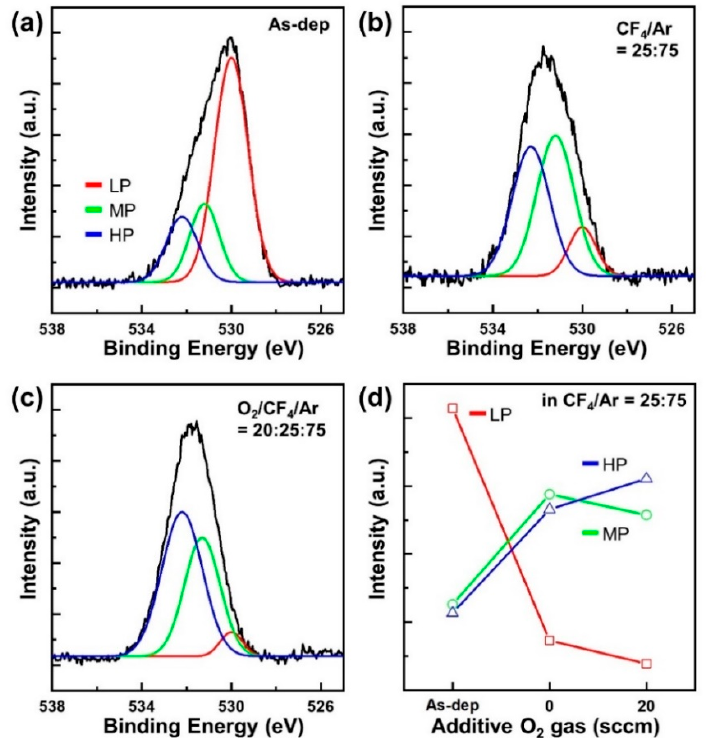
Figure 4. ( a ‒ c ) O 1s peaks of XPS narrow-scan spectra of the IGZO thin film and ( d ) intensity corresponding to low peak, middle peak and high peak as a function of additive O 2 flow rate with fixed CF 4 /Ar = 25:75 sccm. LP, MP, and HP mean low peak (530 eV), middle peak (531.2 eV), and high peak (532.2 eV).